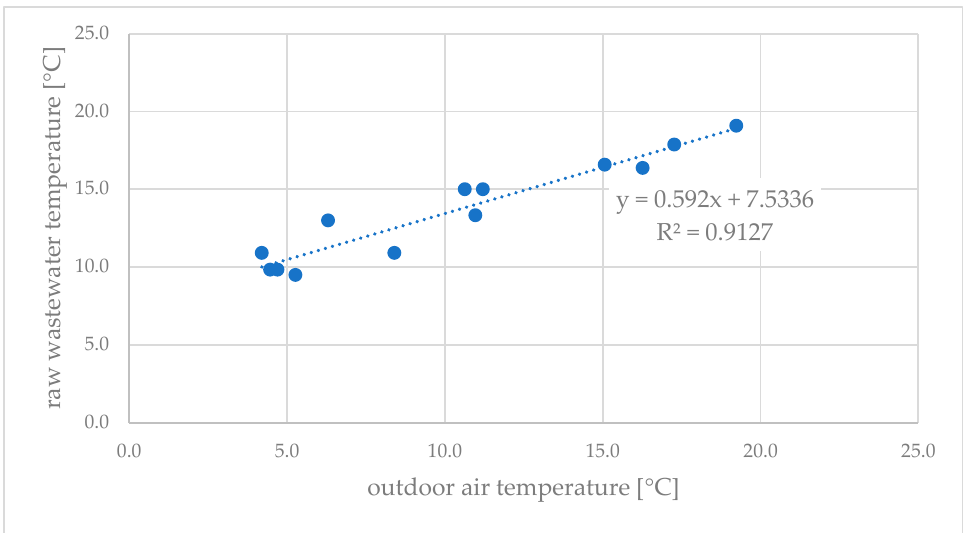
Figure 2. Wastewater flow and temperature variation during the year.